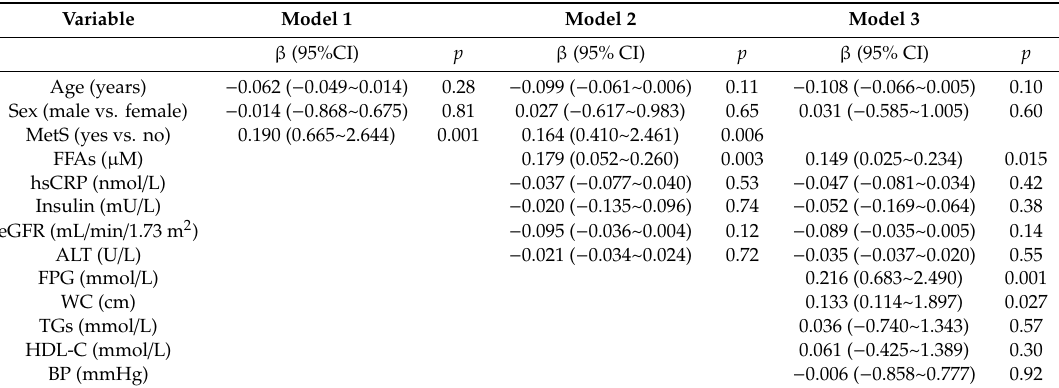
Table 3. Multivariate linear regression analyses of secretogranin III and clinical